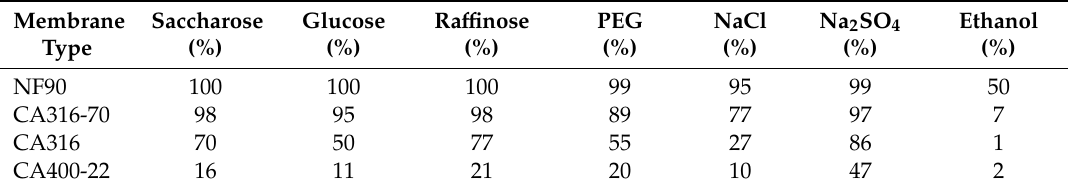
Table 3. Rejections of NF membranes to specific solutes, salts, and ethanol (Test conditions: feed